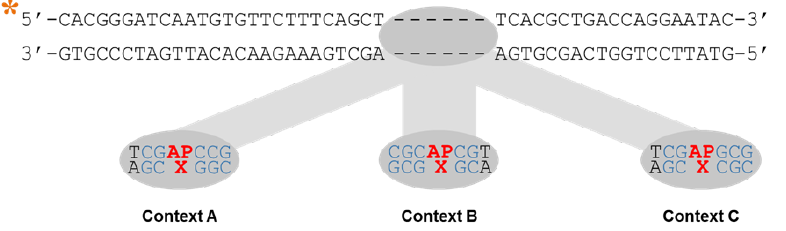
Figure 1. Oligonucleotide duplexes with three different sequence contexts and either G or C opposite the AP site used as DNA substrates. Fluorescein labelling at the 5′ end of the upper strand is indicated by an asterisk. X indicates G or C.